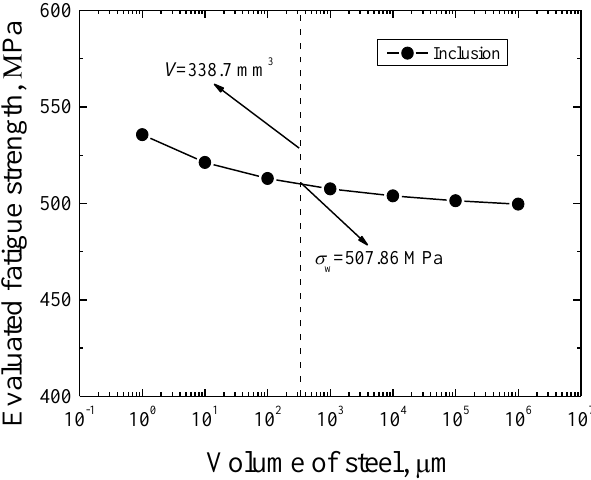
Figure 14. Prediction of fatigue strength for different volumes.